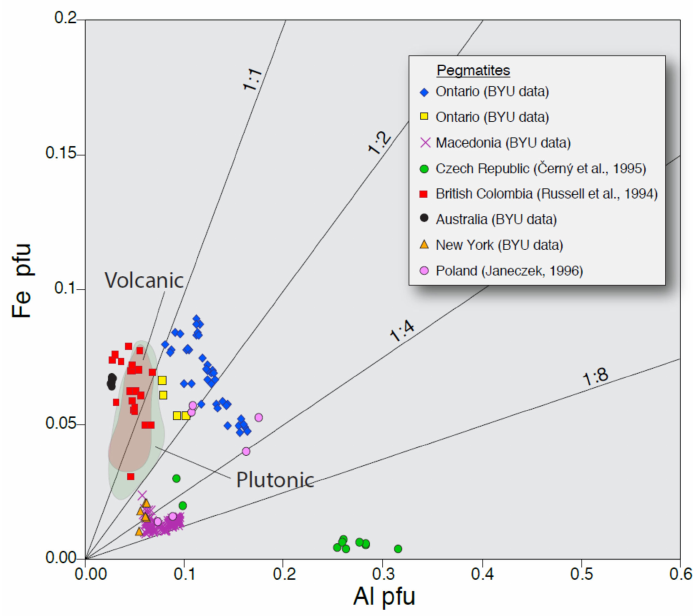
Figure 26. Fe versus Al for titanite from several pegmatites. Fields shown are drawn at 90% of data for titanite from volcanic (red shading) and plutonic rocks (green shading) for comparison. Sources for the data are shown in the